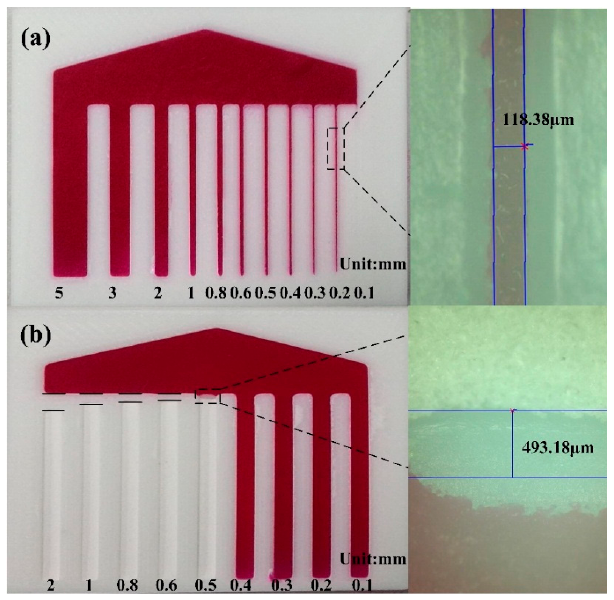
Figure 5. Resolution of μ 3DPADs: ( a ) The resolution of the hydrophilic channels and the channel’s image under the microscope (100×); ( b ) The resolution of the hydrophobic barriers and the barrier's image under the microscope (100×).